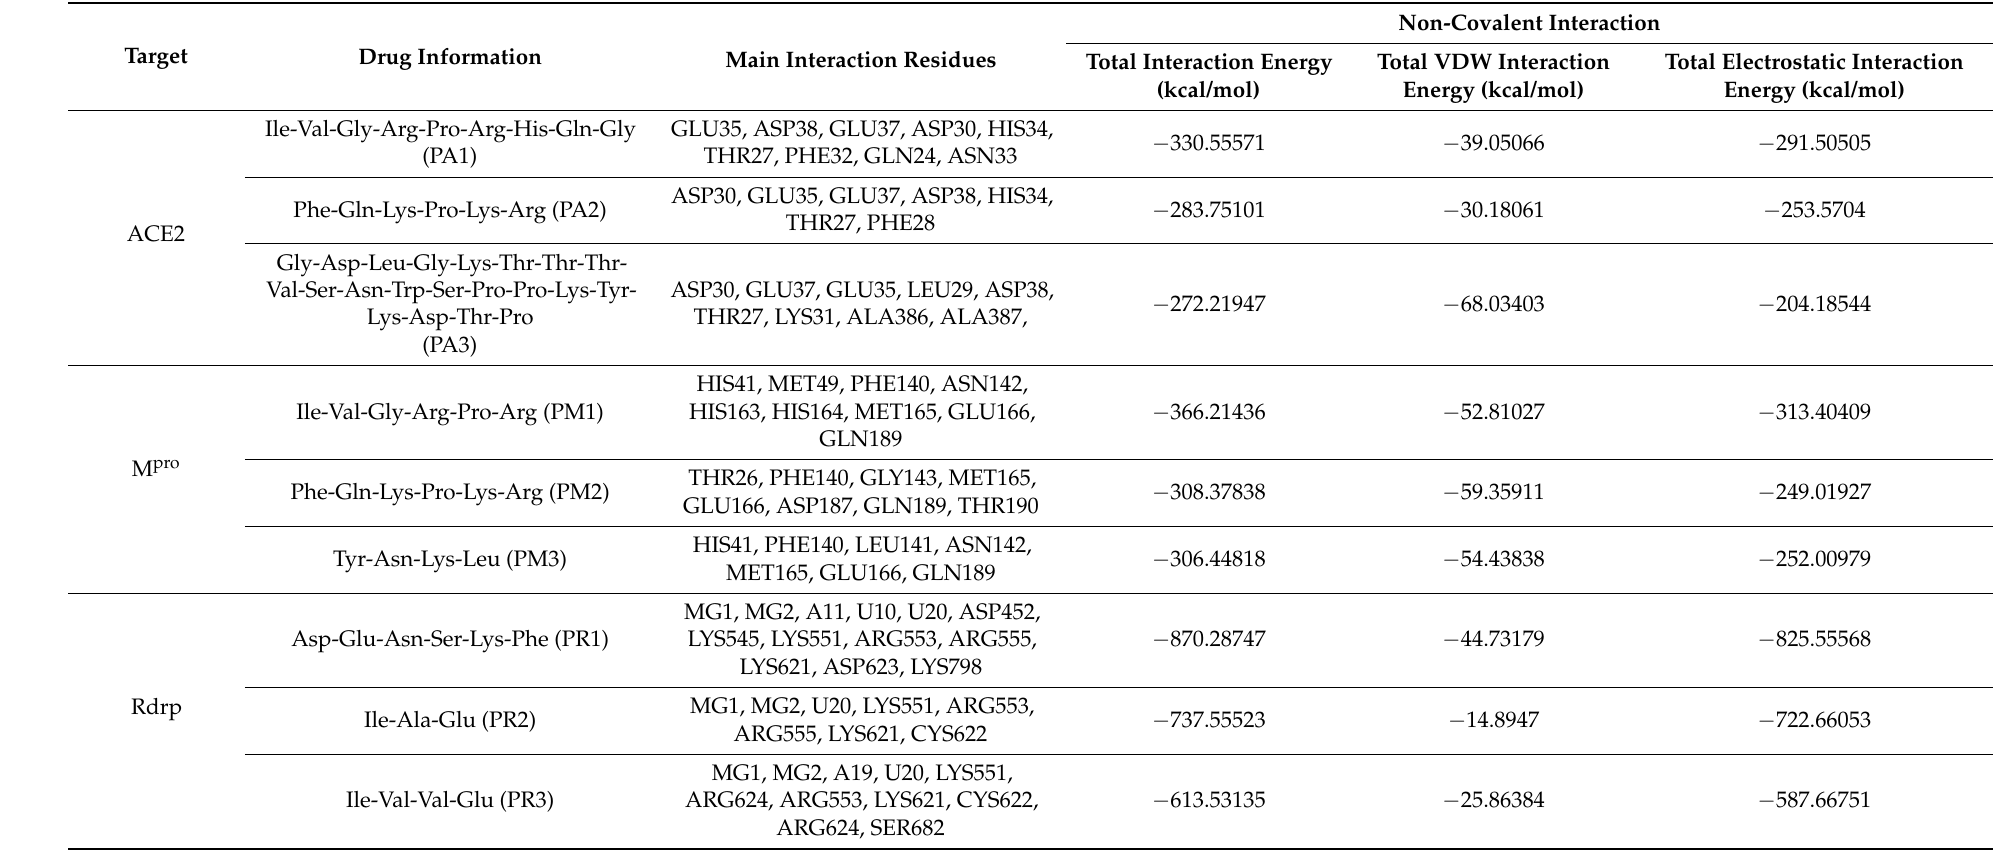
Table 1. Docking results and binding sites for the potential peptides inhibiting the possible control targets of the COVID-19